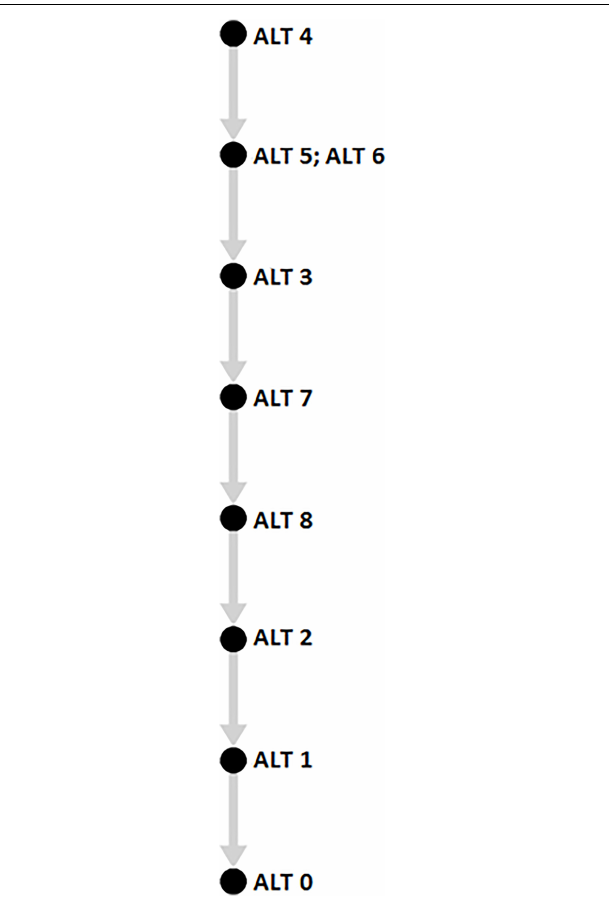
FIGURE 4 | Final pre-order of the alternatives obtained with ELECTRE III with the second scheme of weights (generated by the SuperDecisions R (cid:13) software; figure modified by the